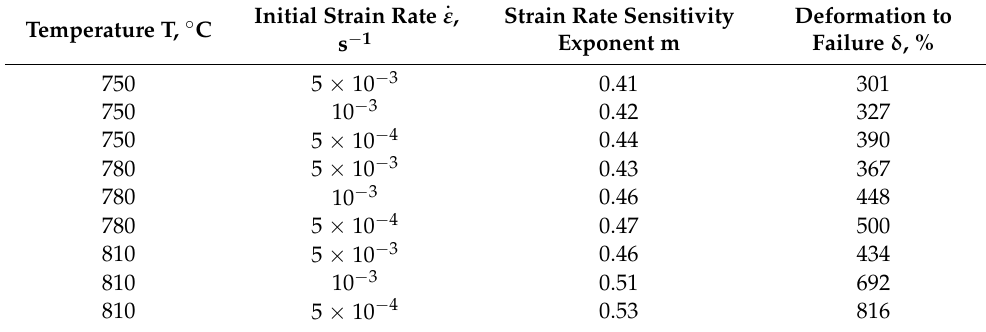
Table 1. Measured δ and calculated m values as a function of deformation temperature and strain rate. . Initial Strain Rate ε , Temperature T, ◦ C